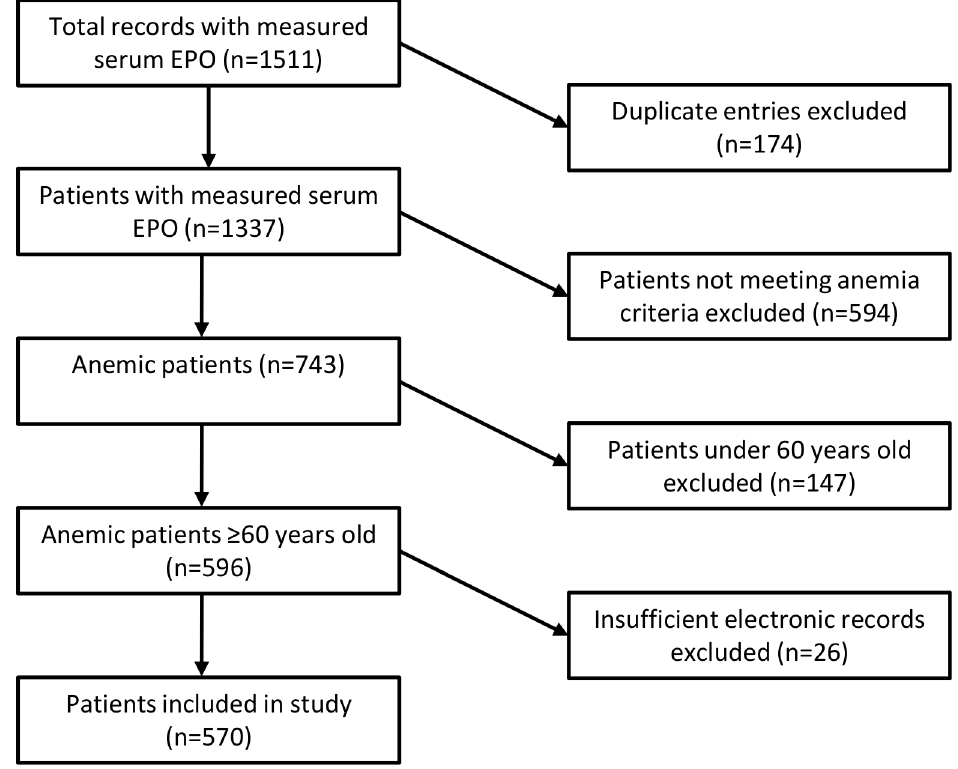
Fig 1. Flowchart of cohort integration. Serum EPO was measured in 1511 cases, of which 570 individual patients met inclusion criteria and were included in the study.